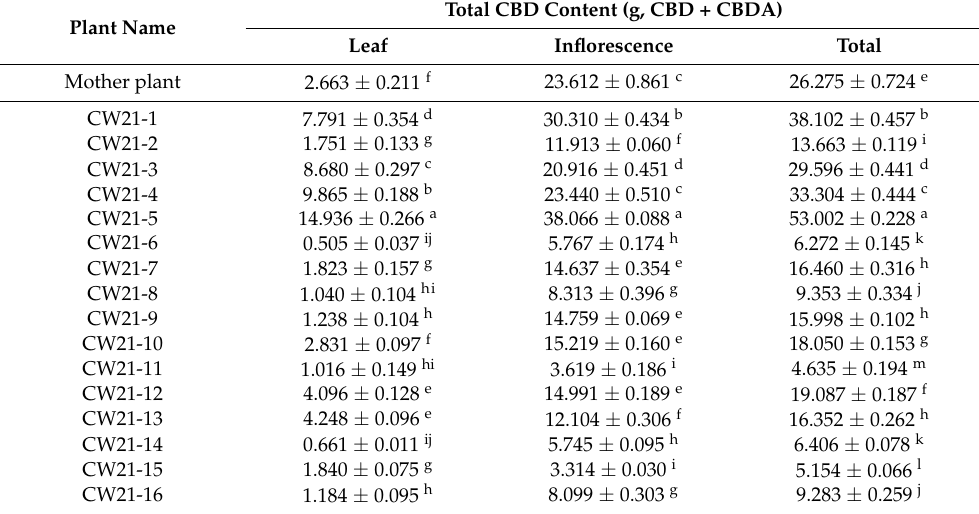
Table 4. Total CBD content per cubic